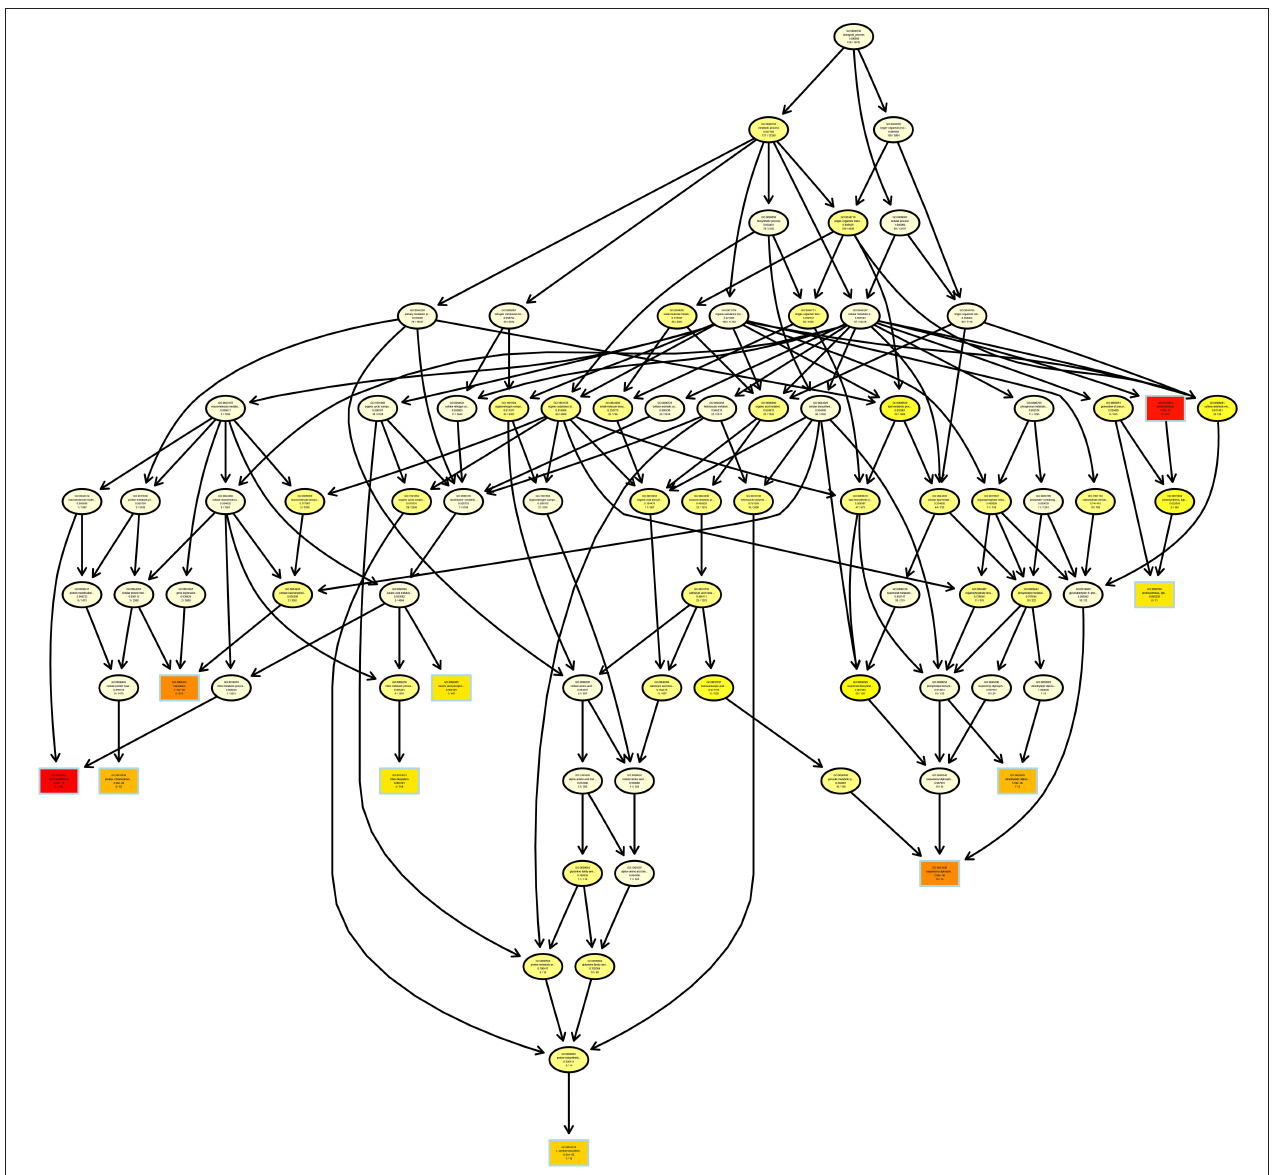
FIGURE 2 | TopGO directed acyclic graph of unigenes related to iridoid glycoside synthesis. Boxes represent top10 GO term with the most significant enrichment. Each box (or ellipse) contains a description and a P -value. Arrow represents containment relationship.